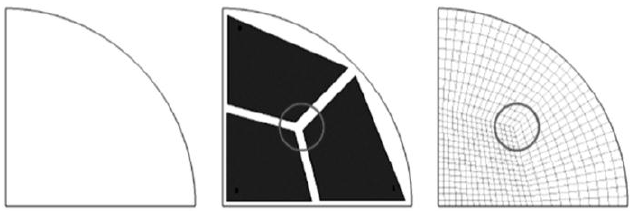
Figure 4. Mesh of a quarter of cross section of the